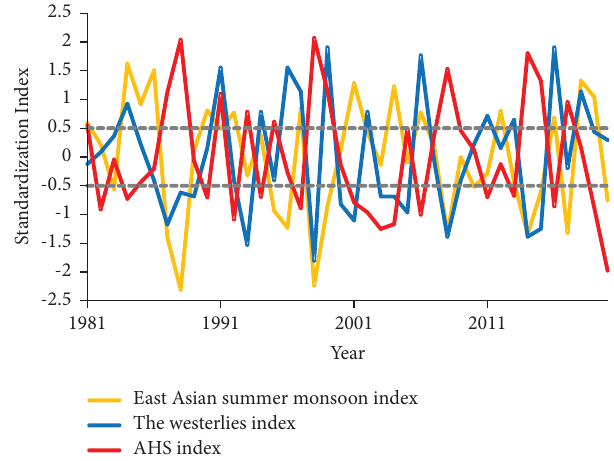
Figure 3: Variation of the EASWJ index, EASM index, and the AHS index of TP in August from 1981 to 2020.